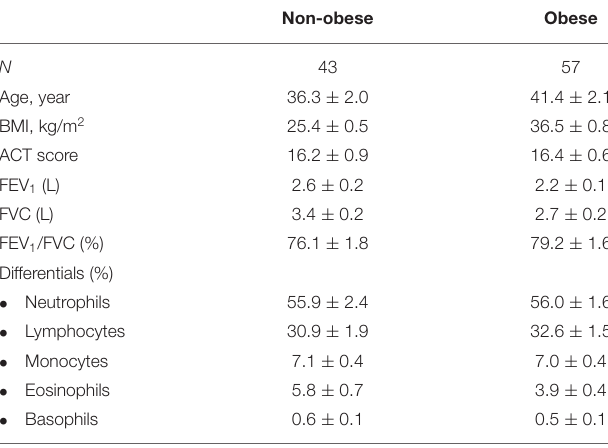
TABLE 3 | Demographic and clinical data of patients. Non-obese